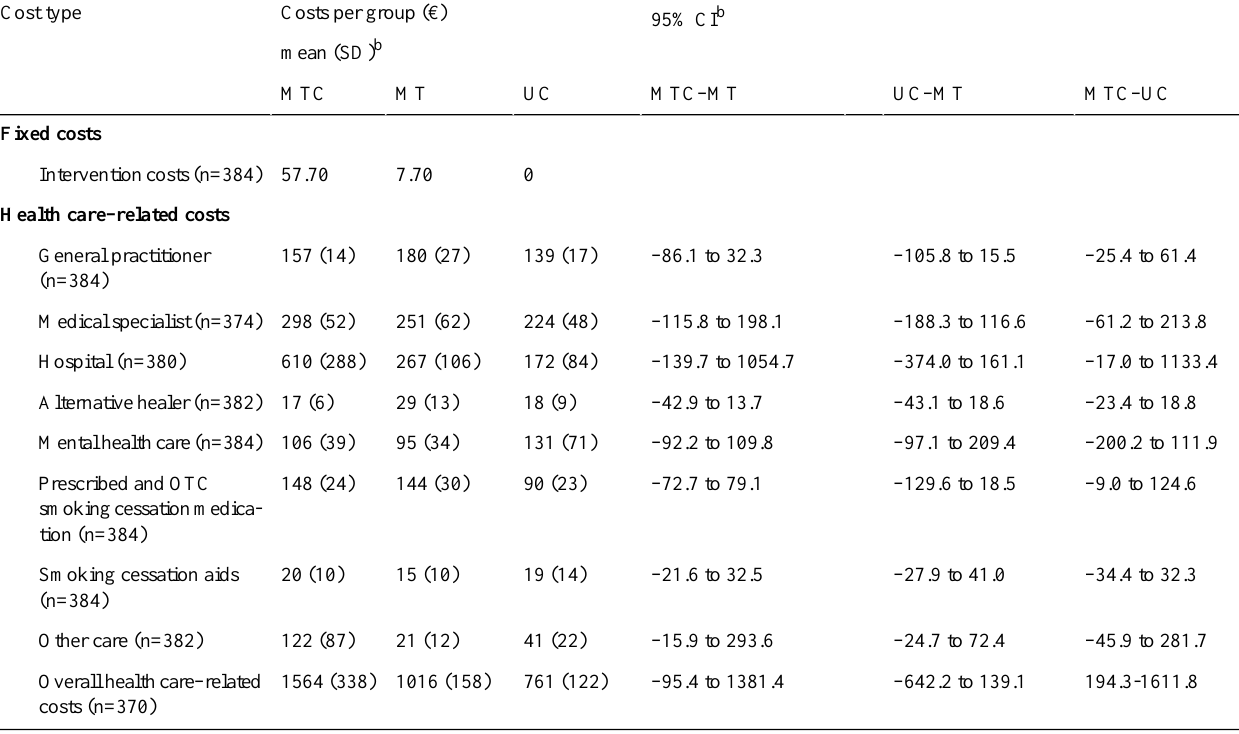
Table 2. Mean annual costs a per participant in the MTC, MT, and UC groups.